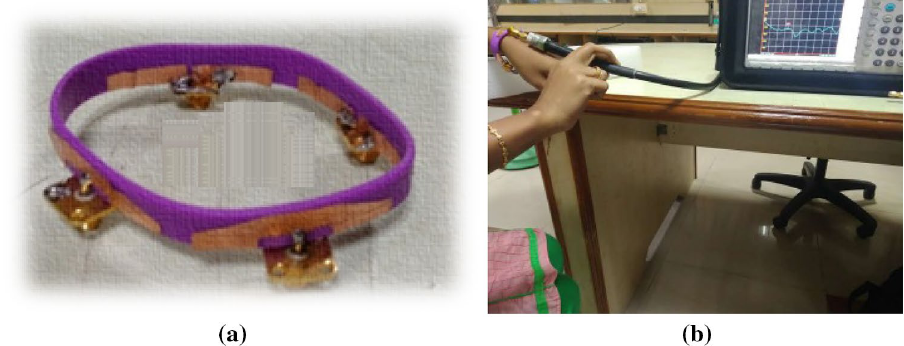
Figure 9. ( a ) Fabricated prototype and ( b ) antenna measurement using vector network analyzer.